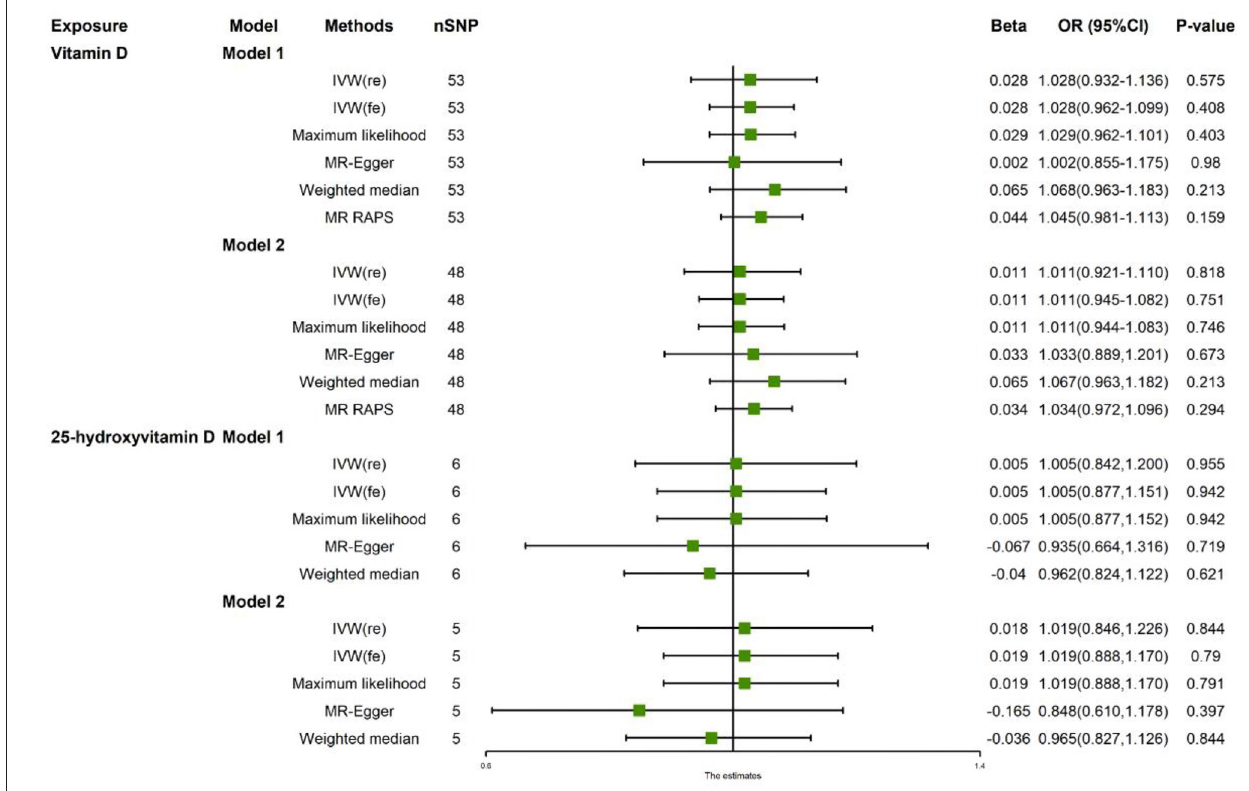
FIGURE 2 | Associations of vitamin D and 25-hydroxyvitamin D levels with AF in two-sample Mendelian randomization analysis. SNPs, single nucleotide polymorphisms; IVW, inverse variance weighted; OR, odds ratio; RAPS, robust adjusted profile